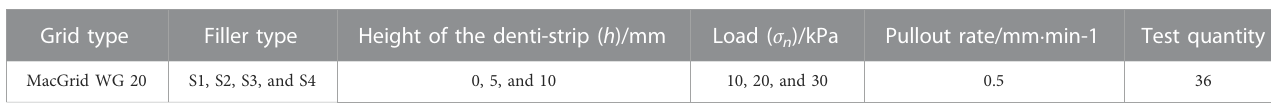
TABLE 4 Pullout test